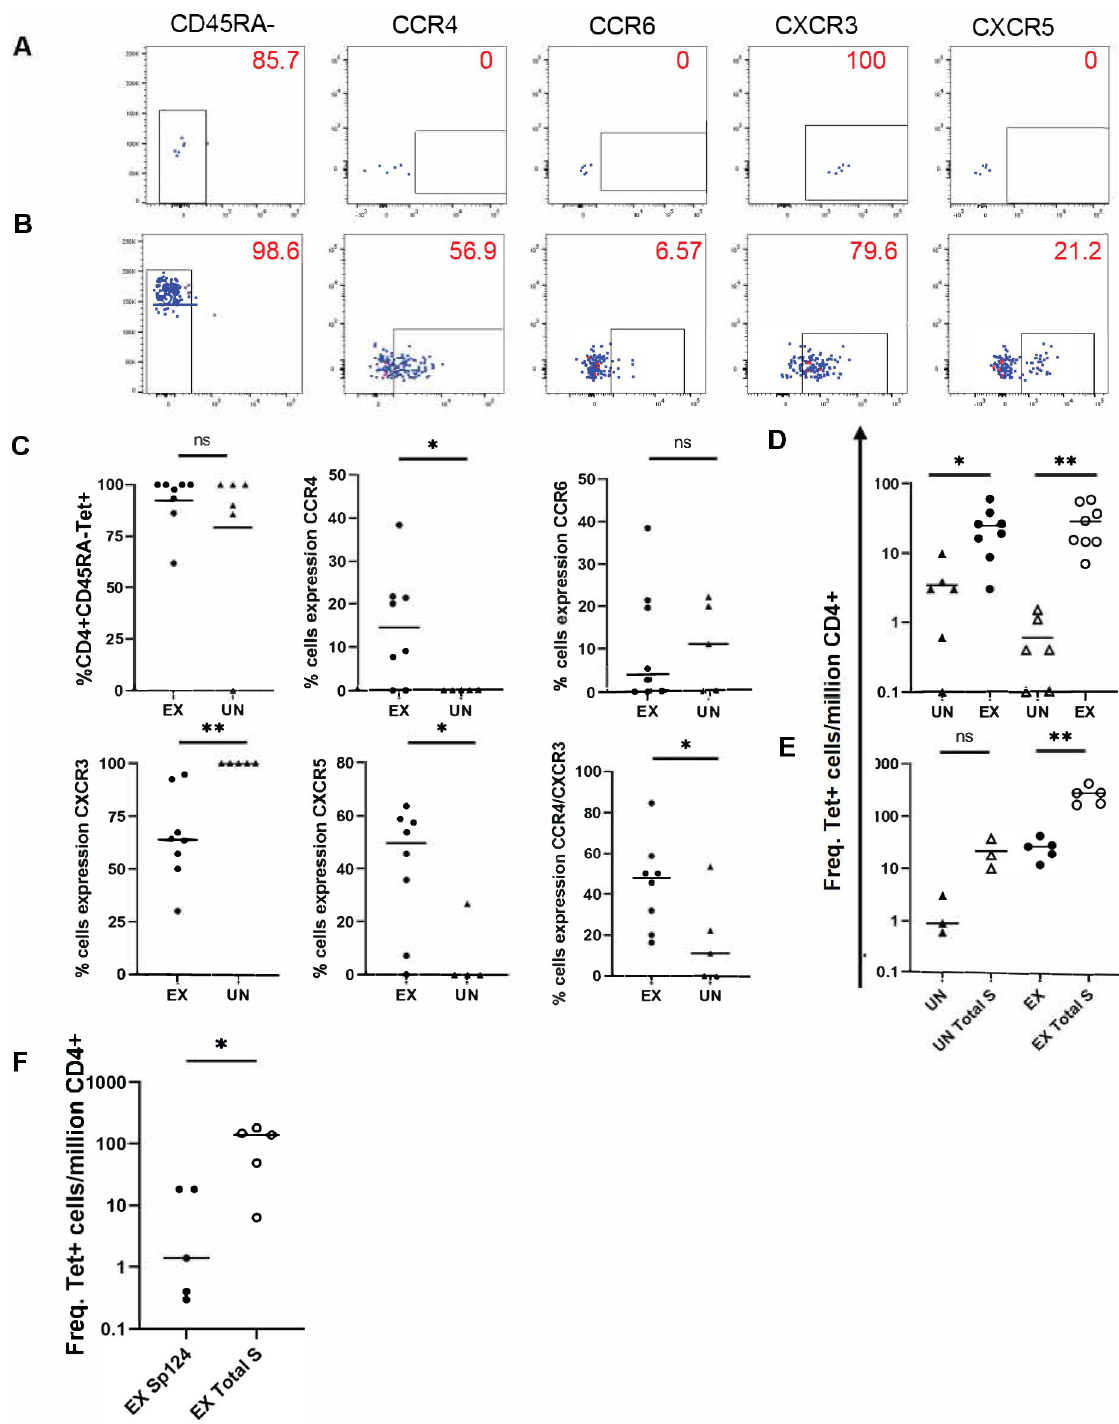
Fig 7. Comparison of DR1501- and DP0401-specific epitope in SARS-CoV-2 exposed and unexposed individuals. (A) Phenotype of DP0401 SARS-CoV-2 S 809-828 cells stained ex vivo with DP0401 SARS-CoV-2 S 809-828 -specific tetramers in an unexposed individual. Numbers indicate percentage of cells with the corresponding surface marker. (B) Phenotype of DP0401 SARS-CoV-2 S 809-828 cells stained ex vivo with DP0401 SARS-CoV-2 S 809-828 -specific tetramers in an exposed individual. Numbers indicate percentage of cells with the corresponding surface marker. (C) Summary of memory (top left) and phenotypes for all DP0401 SARS-CoV-2 S 809-828 specific cells in exposed (ex) and unexposed (un) individuals. (D) Total frequency of DP0401 SARS CoV-2 S 809-828 (closed circle and triangle) and DP0401 SARS-CoV-2 S 161-180 (open circle and triangle) specific cells in exposed (ex) and unexposed (un) individuals. (E) Summary of combined DR1501 SARS-CoV-2 S 1001-1020 and DP0401 SARS-CoV-2 S 809-828 specific cells in individuals with DR1501/DRB5/DP0401 haplotype in ex